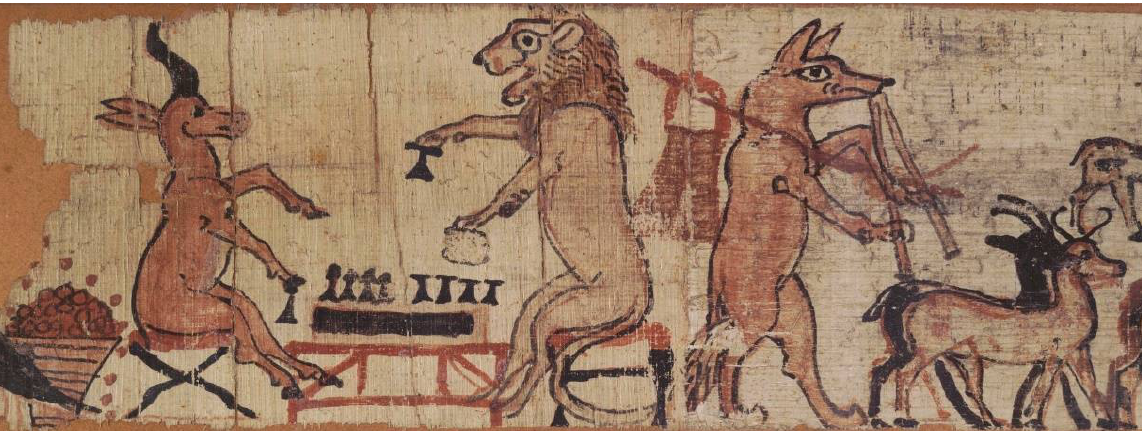
Figure 8. Lion and gazelle playing a board game (detail of BM reg. no. EA10016), illustrated papyrus, Deir el-Medina, Ramesside period (Image courtesy of the Trustees of the British Museum, London).